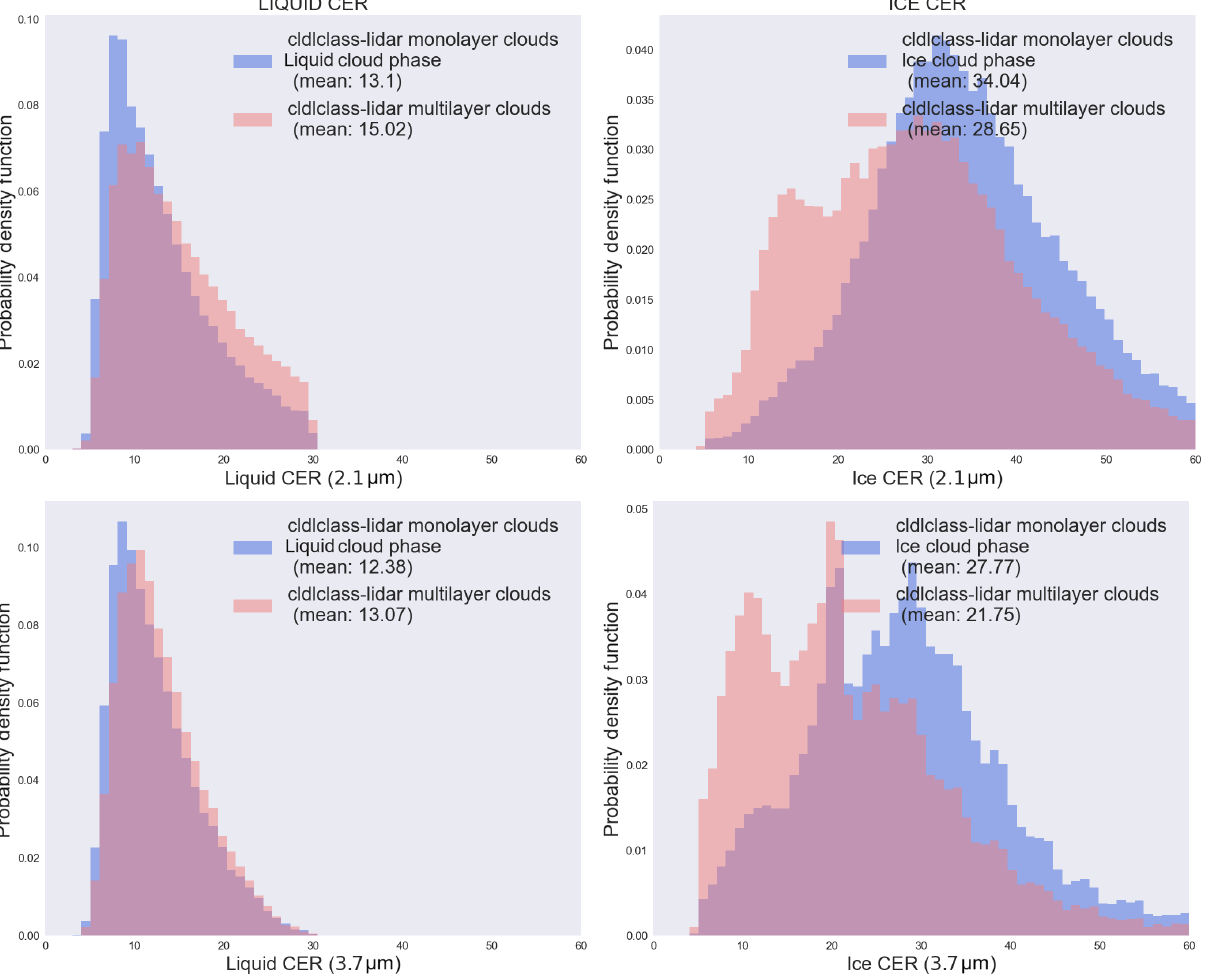
Figure 11. Differences in MYD06 CER distributions for monolayer (in blue) and multilayer (in red) clouds for the population that have MYD06 cloud optical thickness lower than